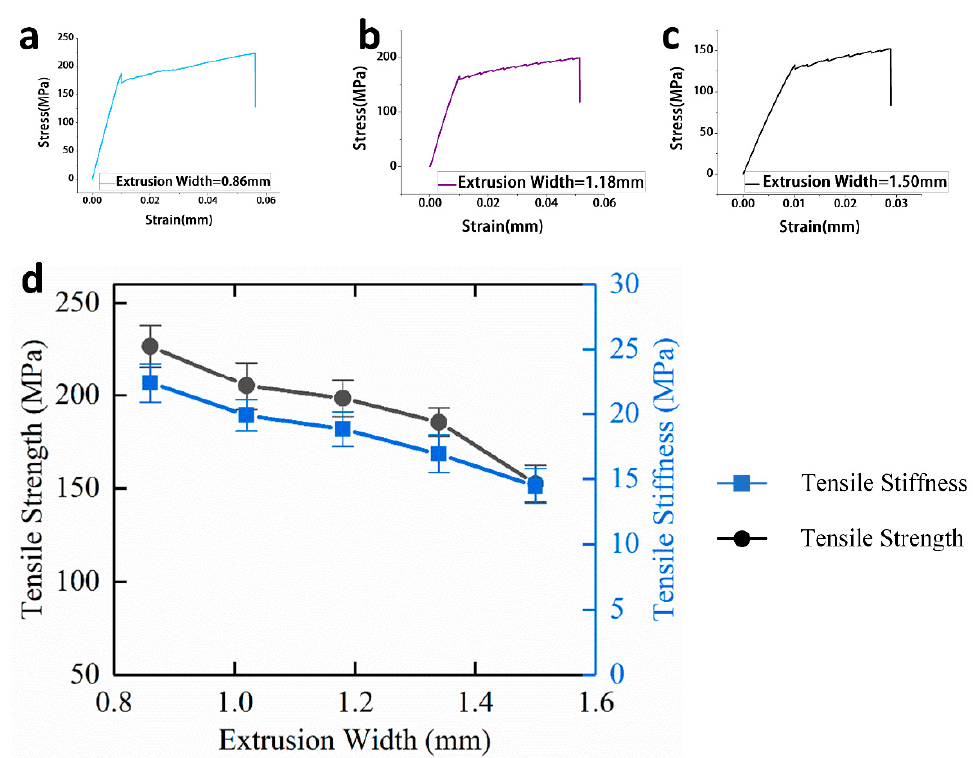
Figure 9. ( a ) Tensile stress-strain curve of specimens while the extrusion width is 0.86 mm; ( b ) Tensile stress-strain curve of specimens while the extrusion width is 1.18 mm; ( c ) Tensile stress-strain curve of specimens while the extrusion width is 1.50 mm; ( d ) Effect of extrusion width on tensile mechanical properties of continuous carbon-reinforced 3D printing.